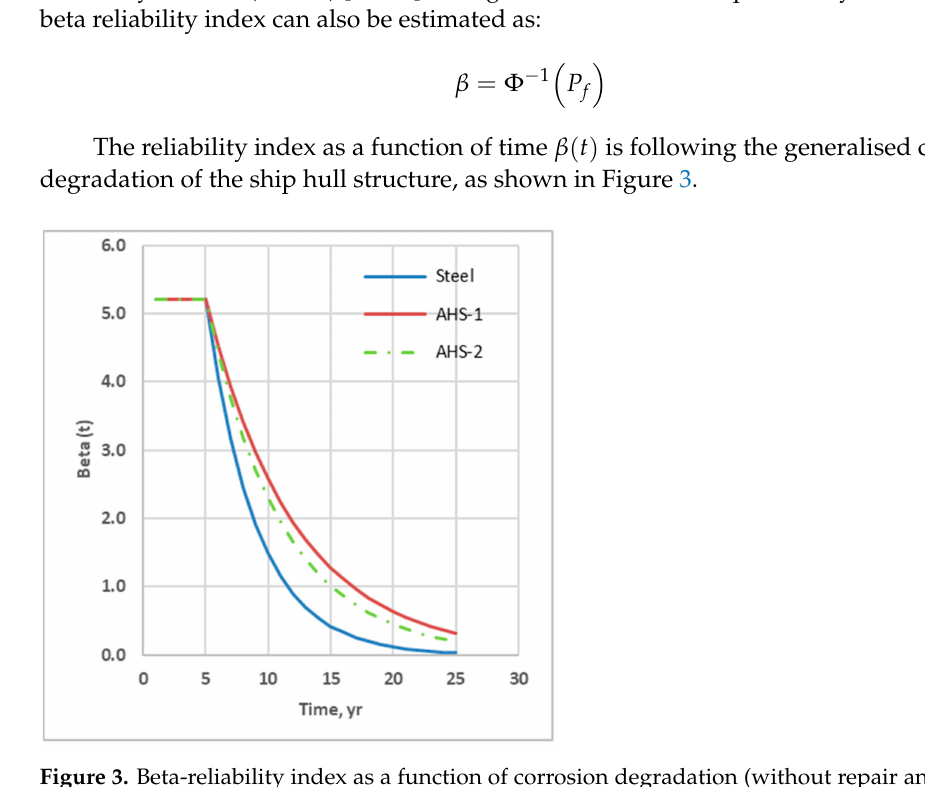
Figure 3. Beta-reliability index as a function of corrosion degradation (without repair and mainte-